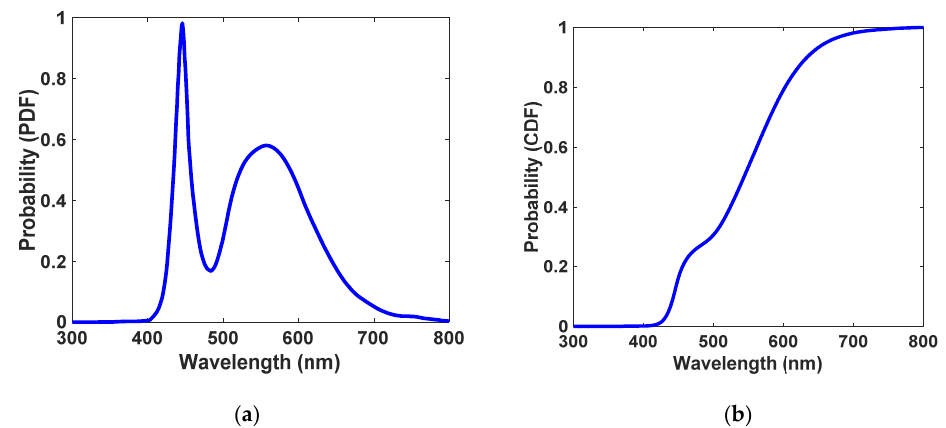
Figure 5. ( a ) Probability density function (PDF) for white LED. It is directly generated from the emission spectrum of white LED (the only difference is its normalization to the area of the curve). ( b ) Cumulative density function (CDF) for white LED adapted from its PDF curve.